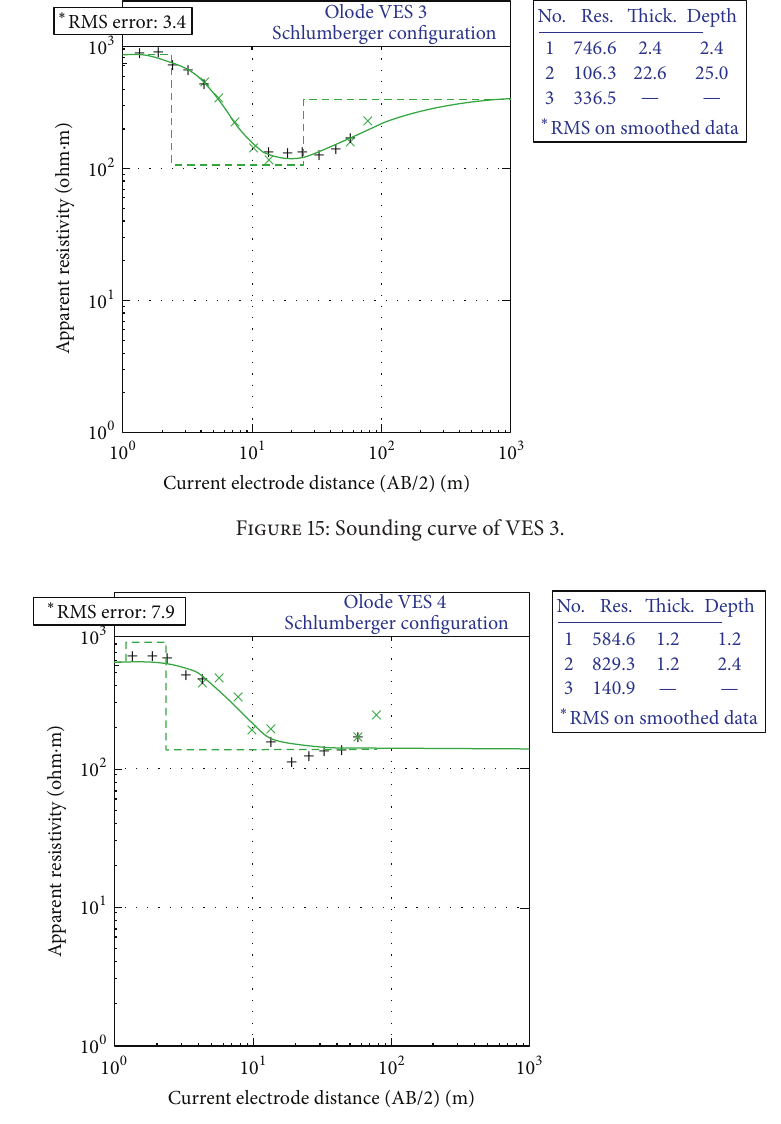
Figure 16: Sounding curve of VES